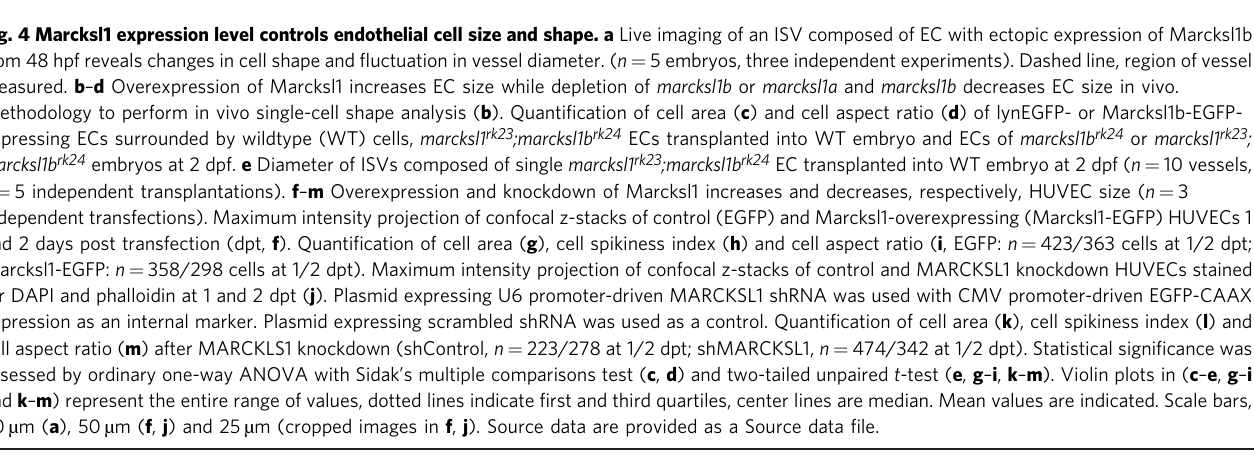
Fig. 4 Marcksl1 expression level controls endothelial cell size and shape. a Live imaging of an ISV composed of EC with ectopic expression of Marcksl1b from 48 hpf reveals changes in cell shape and fl uctuation in vessel diameter. ( n = 5 embryos, three independent experiments). Dashed line, region of vessel measured. b – d Overexpression of Marcksl1 increases EC size while depletion of marcksl1b or marcksl1a and marcksl1b decreases EC size in vivo. Methodology to perform in vivo single-cell shape analysis ( b ). Quanti fi cation of cell area ( c ) and cell aspect ratio ( d ) of lynEGFP- or Marcksl1b-EGFP- expressing ECs surrounded by wildtype (WT) cells, marcksl1 rk23 ;marcksl1b rk24 ECs transplanted into WT embryo and ECs of marcksl1b rk24 or marcksl1 rk23 ; marcksl1b rk24 embryos at 2 dpf. e Diameter of ISVs composed of single marcksl1 rk23 ;marcksl1b rk24 EC transplanted into WT embryo at 2 dpf ( n = 10